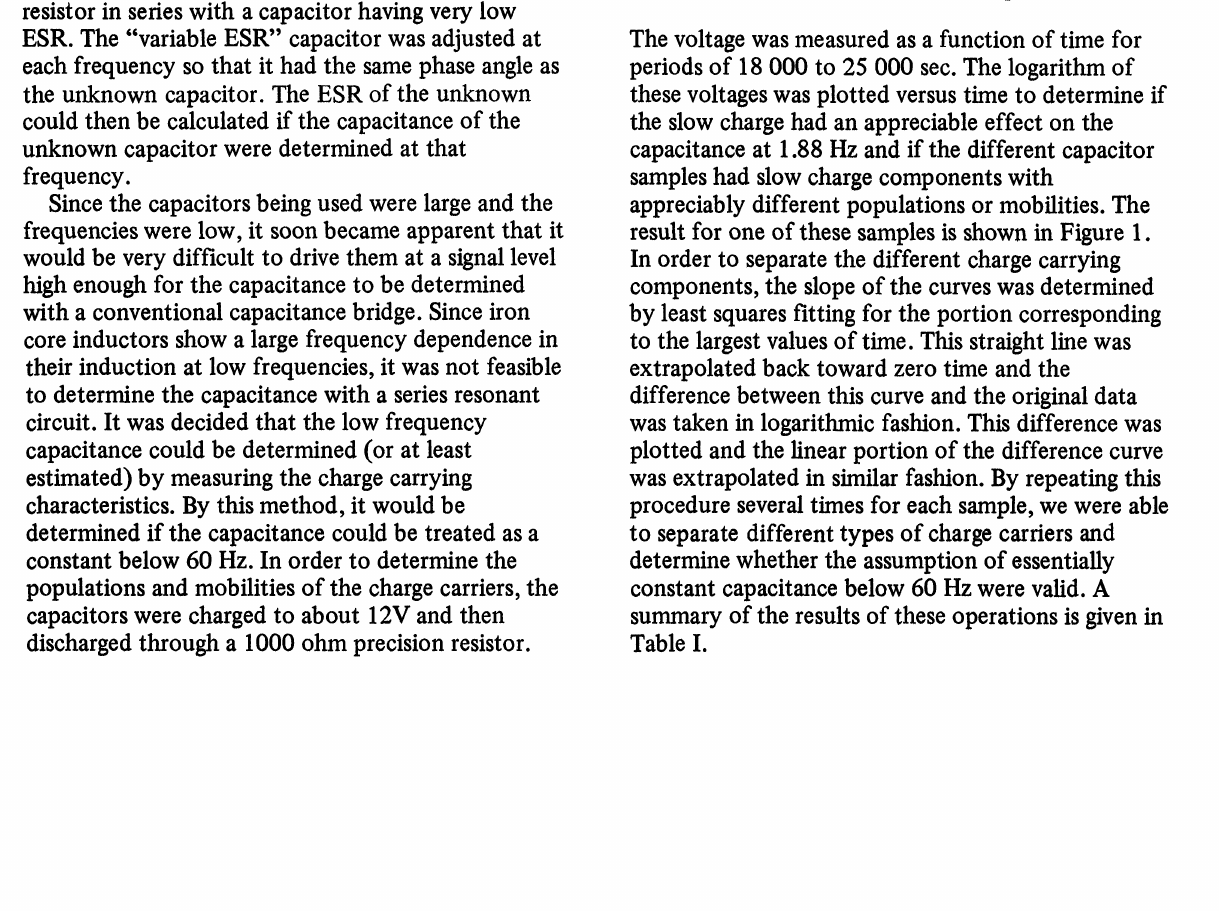
Natural logarithm of the voltage across capacitor number 3 (+), the extrapolations (-), and the differences (t) versus time. Every 20th point is